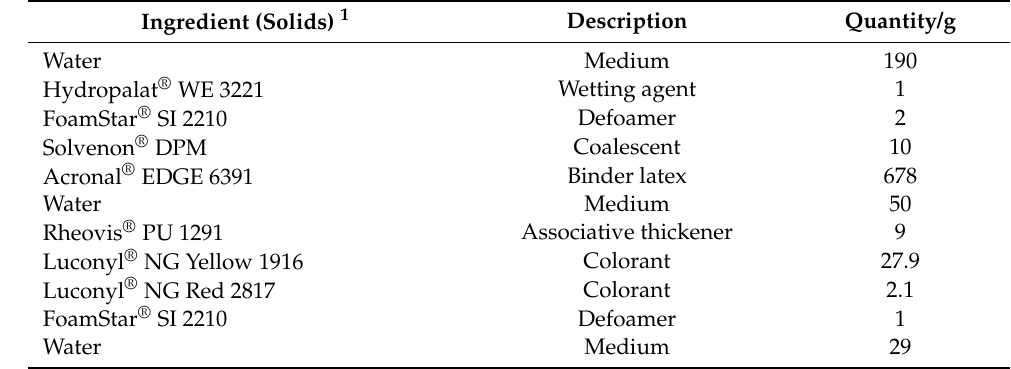
Table A3. Wood stain formulation for binders E to F. The solids content was 31.5%; the pH was adjusted to 8.2–8.5 using ammonia (and to pH 10 in the case of D2). All brand names are each respective trademarks of Kronos International Inc., Sun Chemical Inc. (Luconyl ® ) (Parsippany-Troy Hills, NJ, USA) and BASF SE (Hydropalat ® , FoamStar ® , Solvenon ® ).